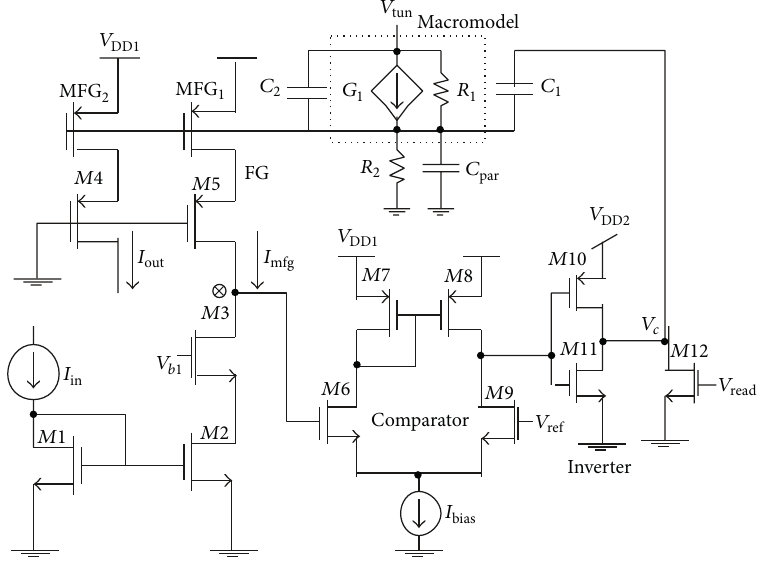
Figure 6: Analog current-mode memory